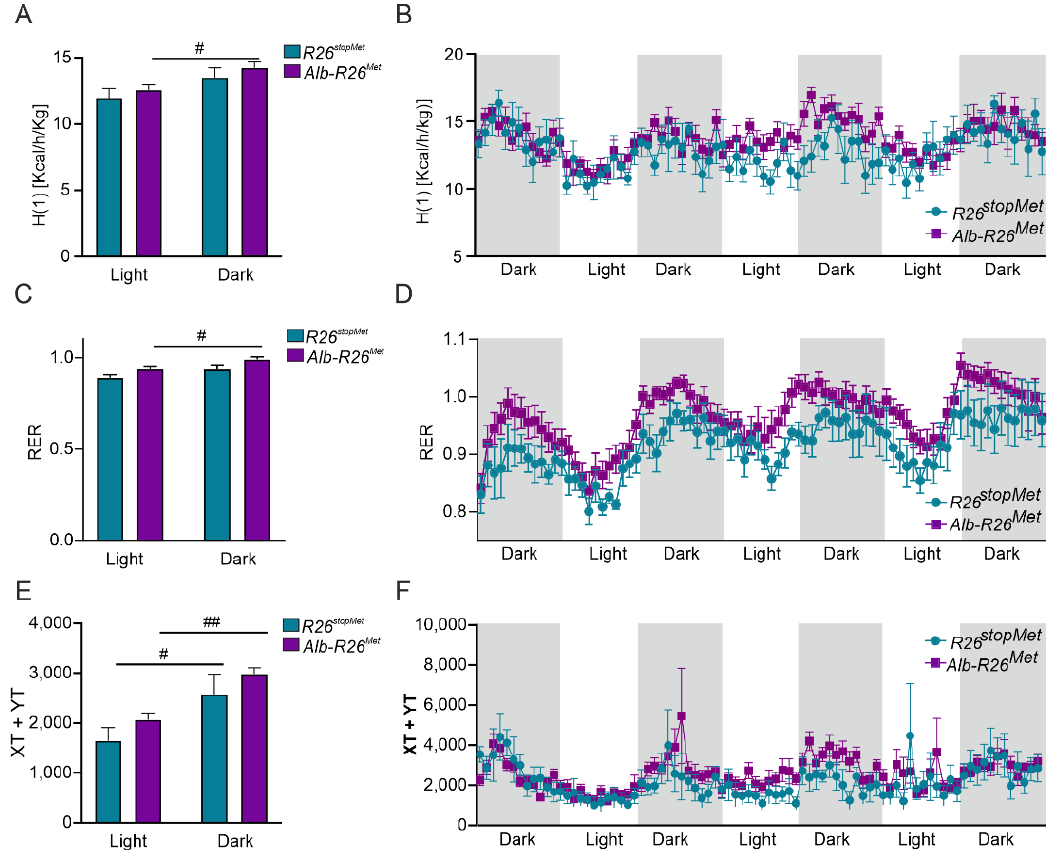
Figure 4. Effect of hepatocyte-specific enhanced MET levels in whole-body energy balance. ( A ) Energy expenditure (H(1) [Kcal/h/Kg]). ( B ) H(1) vs. time in R26 stopMet and Alb-R26 Met mice. ( C ) Respiratory Exchange Ratio (RER) in R26 stopMet and Alb-R26 Met mice. ( D ) RER vs. time in R26 stopMet and Alb-R26 Met mice. ( E ) Spontaneous locomotor activity (XT + YT) in R26 stopMet and Alb-R26 Met mice. ( F ) XT + YT vs. time in R26 stopMet and Alb-R26 Met mice. ( A – F ) Values correspond to mean ± SEM ( n = 6 and 10 mice per group, respectively). For a, c, and e, statistical analysis was performed by a two-way ANOVA followed by a Bonferroni post hoc test. # p < 0.05, ## p < 0.01 vs. light phase.